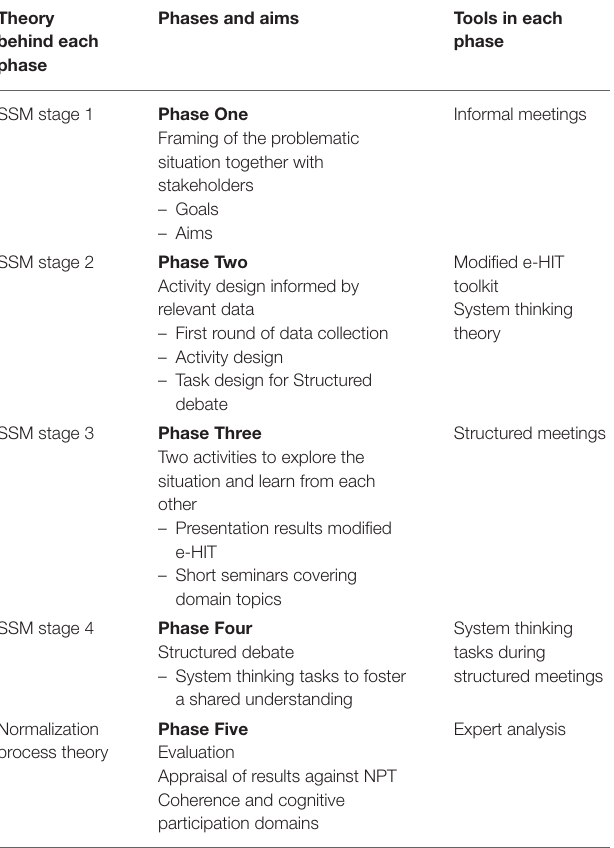
TABLE 1 | Outline of the underpinning theories, aims, and activities for the five phases assessment framework for the study. Theory behind each